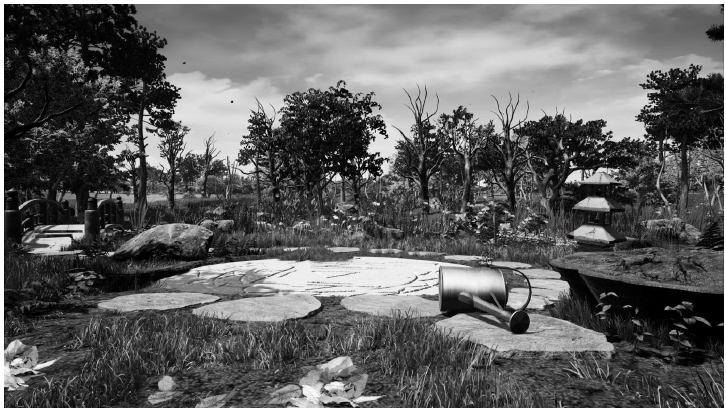
Figure 1. Virtual garden at the initial stage of therapy. J. Clin. Med. 2021 , 10 , 352